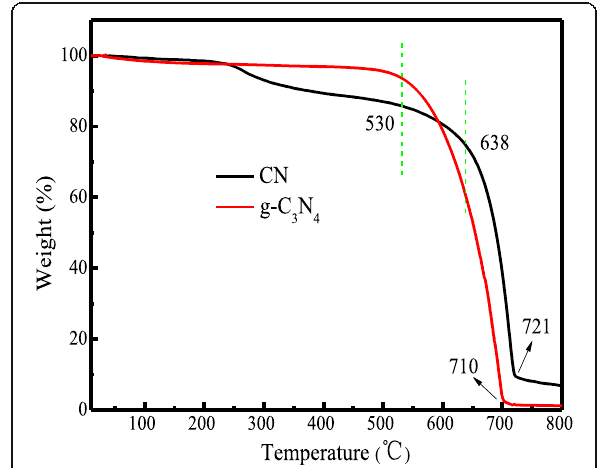
Fig. 5 TGA curves of CN material at 80 °C under the solvent